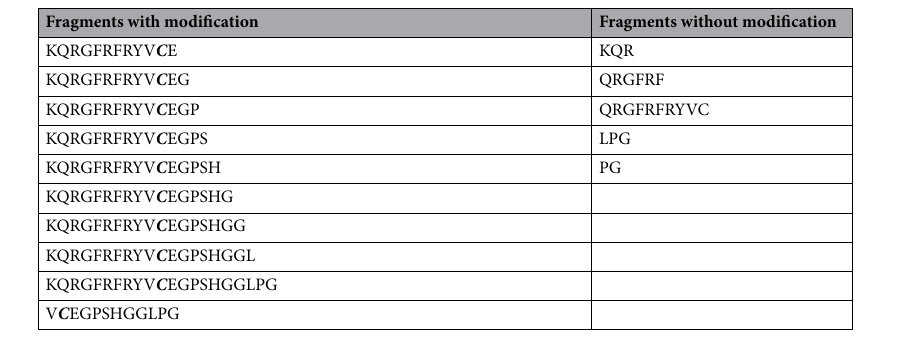
Table 1. Identification of 4-OXO-DHA modified peptide containing the active site sequence (KQRGFRFRYV C EGPSHGGLPG) of p50 by MS/MS (cysteine is labeled in bold and Italic).